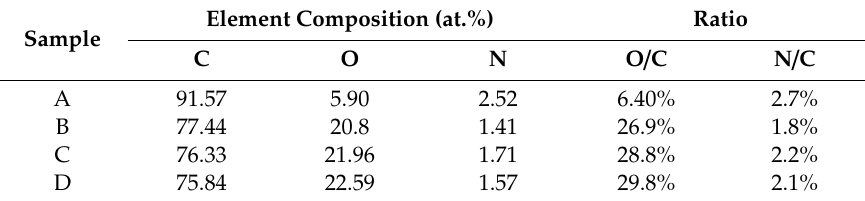
Table 3. The element composition of pristine BOPP film and corona BOPP